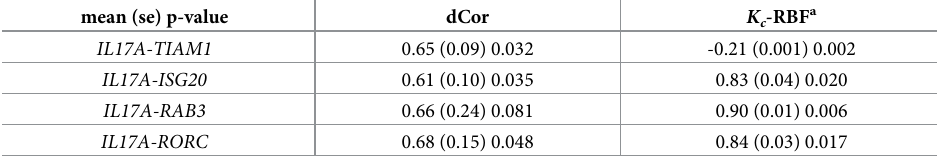
Table 4. DCor and K c -RBF estimated for the four gene pairs of IL17A , which played an important role in the early differentiation of Th17 cells in